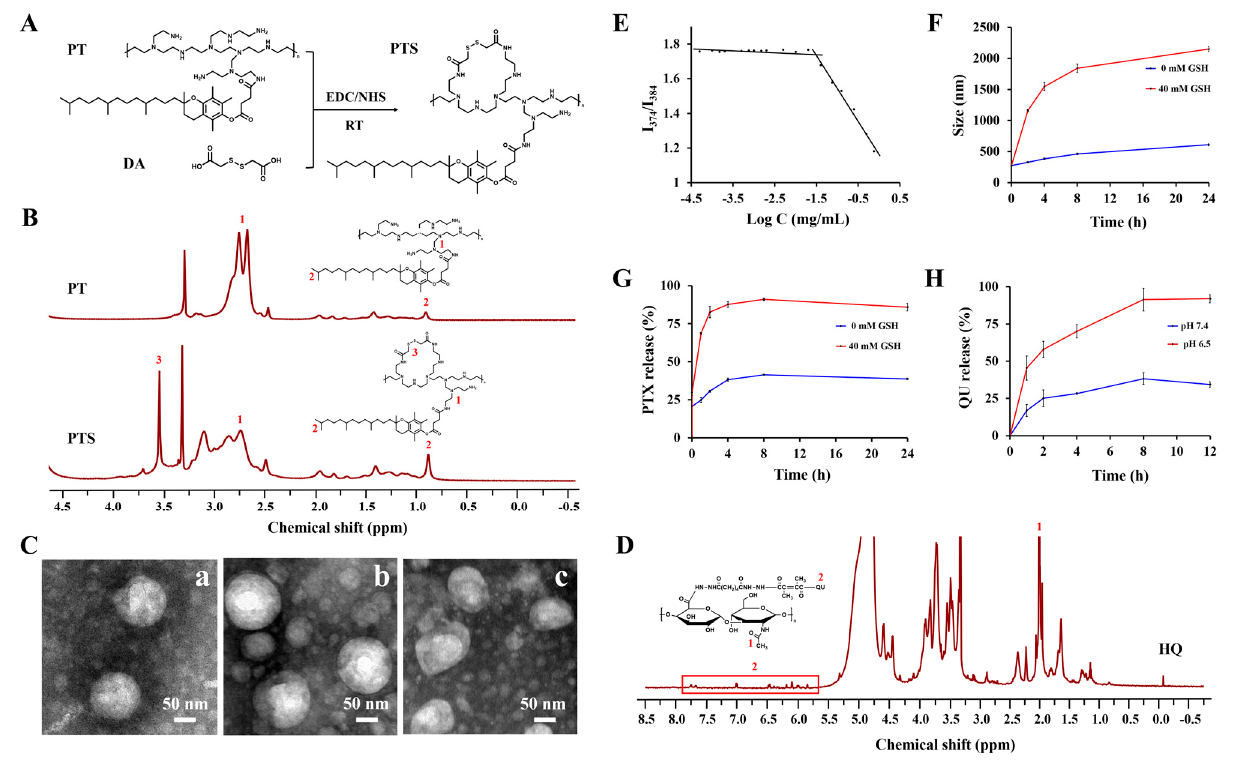
Figure 2. The preparation, characterization, and physiochemical properties of PTS copolymers and HQ conjugates. ( A ) Synthesis route of PTS copolymers. ( B ) 1 H NMR spectra of PT and PTS copolymers. ( C ) TEM images of ( a ) PT, ( b ) PTS, and ( c ) PTS/HA blank PNPs. ( D ) 1 H NMR spectra of HQ conjugates. ( E ) Intensity ratio plot of I 374 /I 384 of pyrene versus log C for PTS copolymers. The change in ( F ) size and ( G ) PTX release of PTX/PTS PNPs treated with or without GSH. ( H ) QU release from HQ conjugates at pH 6.5 and pH 7.4. Data are presented as the mean values ± SD ( n = 3).